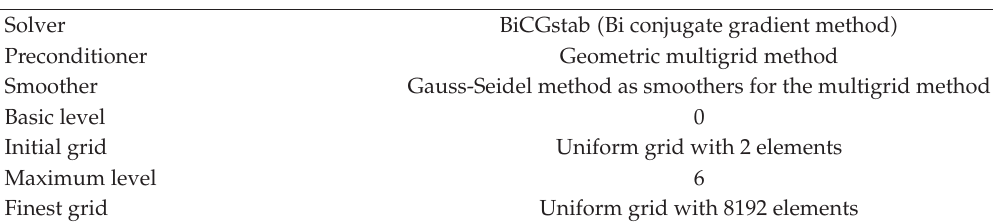
Table 11: Solver methods and their parameters.